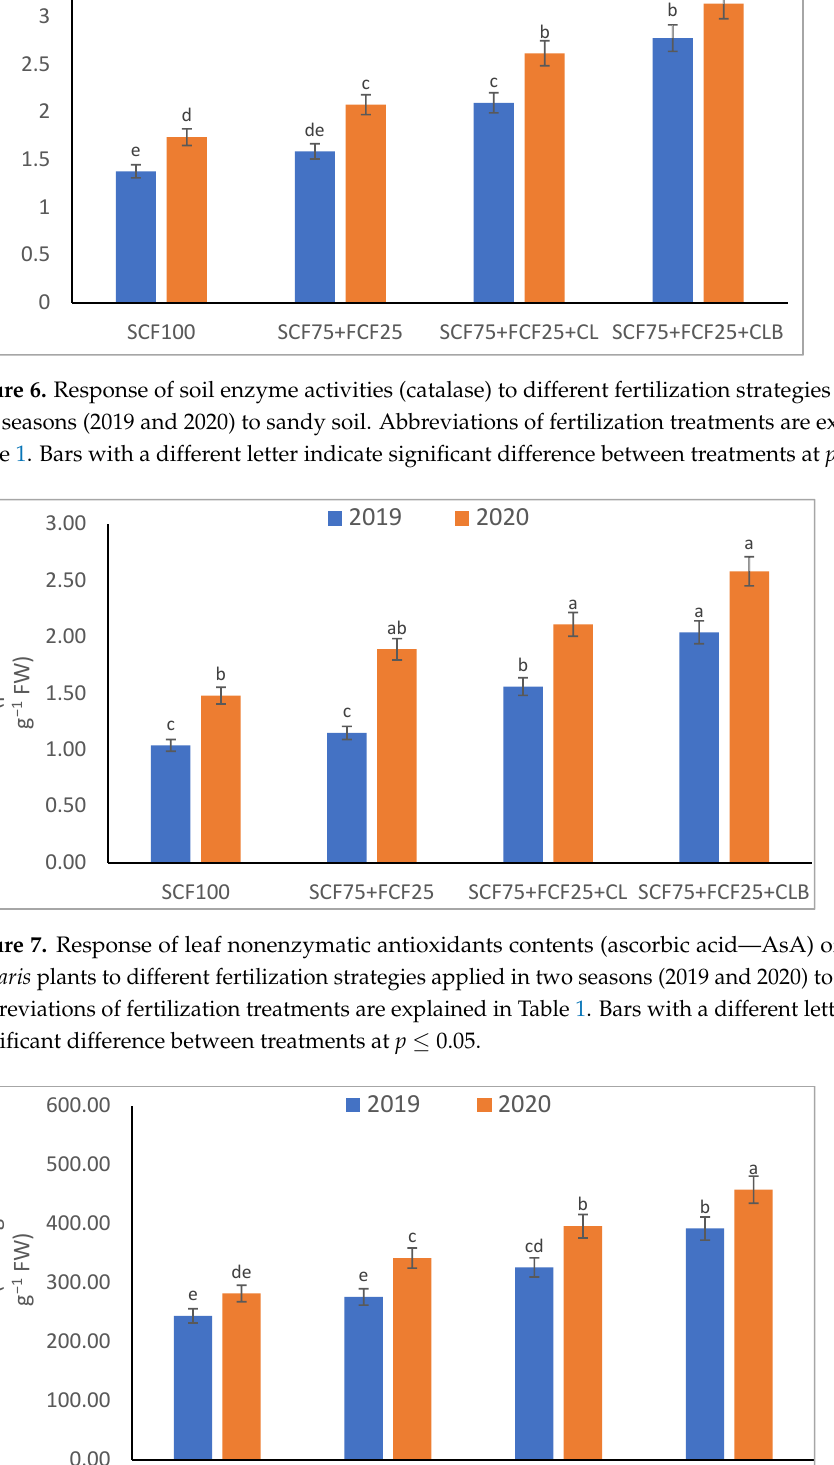
Figure 5. Response of soil enzyme activities (urease) to different fertilization strategies applied in two seasons (2019 and 2020) to sandy soil. Abbreviations of fertilization treatments are explained in Table 1. Bars with a different letter indicate significant difference between treatments at p ≤ 0.05.